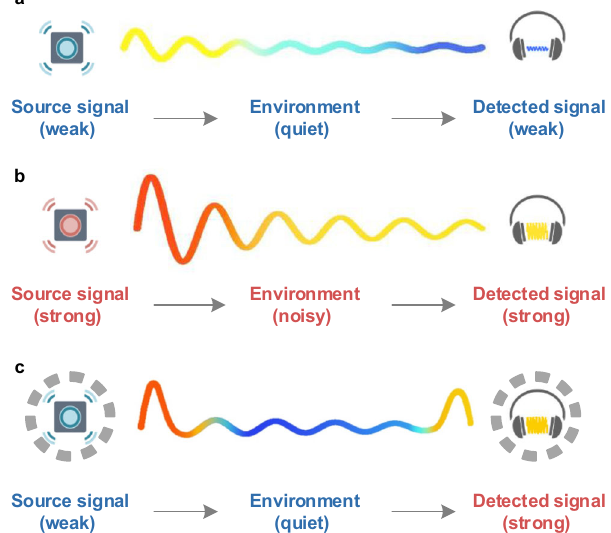
Fig. 1 Conventional and enhanced sound transception. a Conventional scheme transceiving weak sound. The detected signal at the receiving end is much weaker after distant spread while the ambient environment remains quiet. b Conventional scheme transceiving strong sound. The detected signal is enhanced but meanwhile the ambient environment turns noisy. c Scheme based on the use of the remote whispering metamaterial. Enhanced emission and reception of a weak sound signal, at which the pressure fi eld of sound is enhanced only near the emitting and receiving sites. Note that the detected signal is strong while ambient soundscape remains